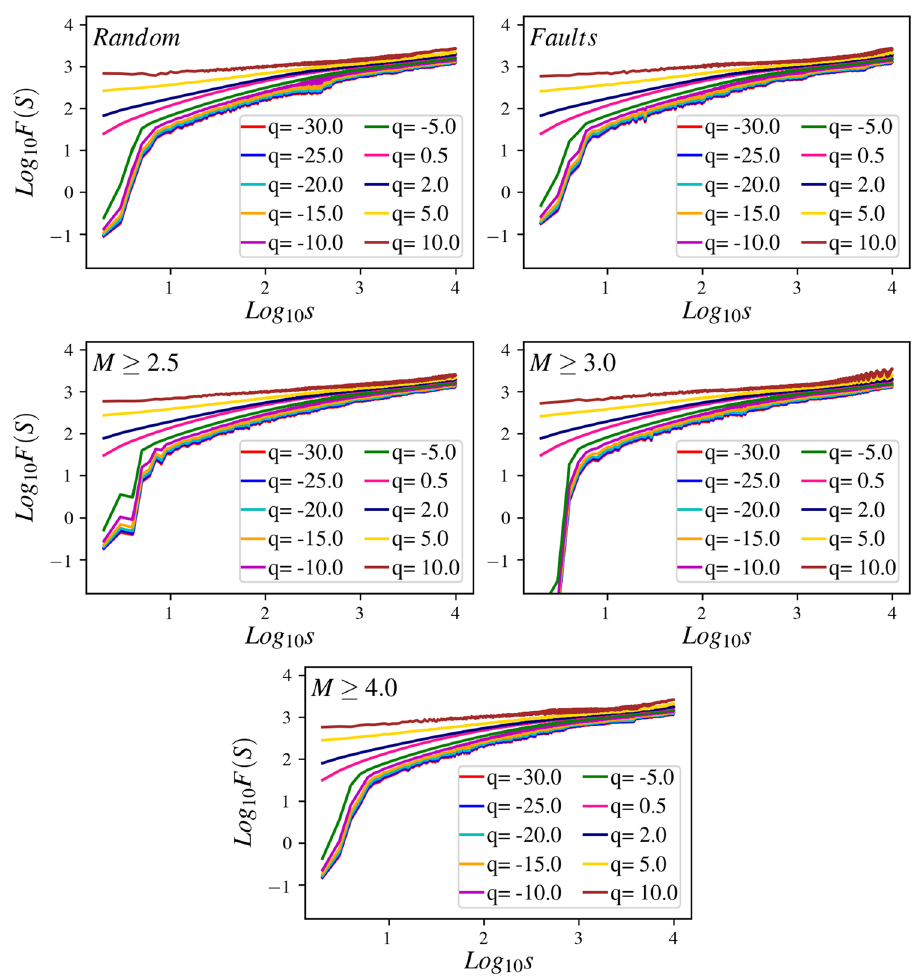
Figure 10. Calculation of the statistical function F q using Eq. (13) for the dynamics with avalanches in the whole space. The function of F q vs s display power laws F q ( s ) ∼ s h ( q ) , where h ( q ) depend on q . This feature demonstrates that the time series is a multifractal.